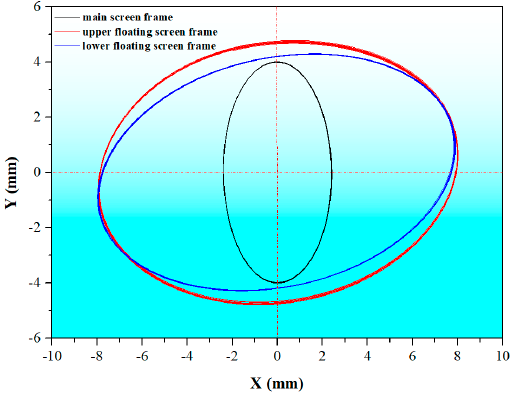
Figure 7. Motion track of the upper, lower floating and the main screen frames